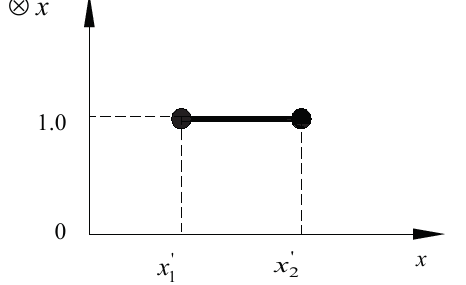
Figure 3 . Membership function of fuzzy number